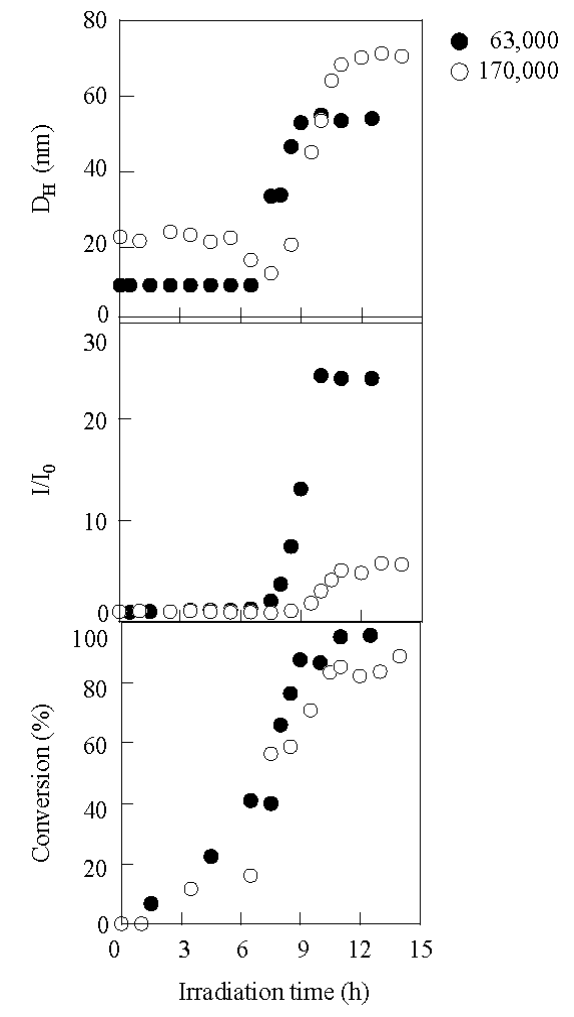
Figure 8. The variation in the hydrodynamic diameter, scattering intensity, and conversion during irradiation using copolymers with Mn(PSt block) = 63,000 (  ) and 170,000 (O). Mn(PBSt block) = 15,000, [copolymer] = 3.30 g/L, DPI/BSt = 0